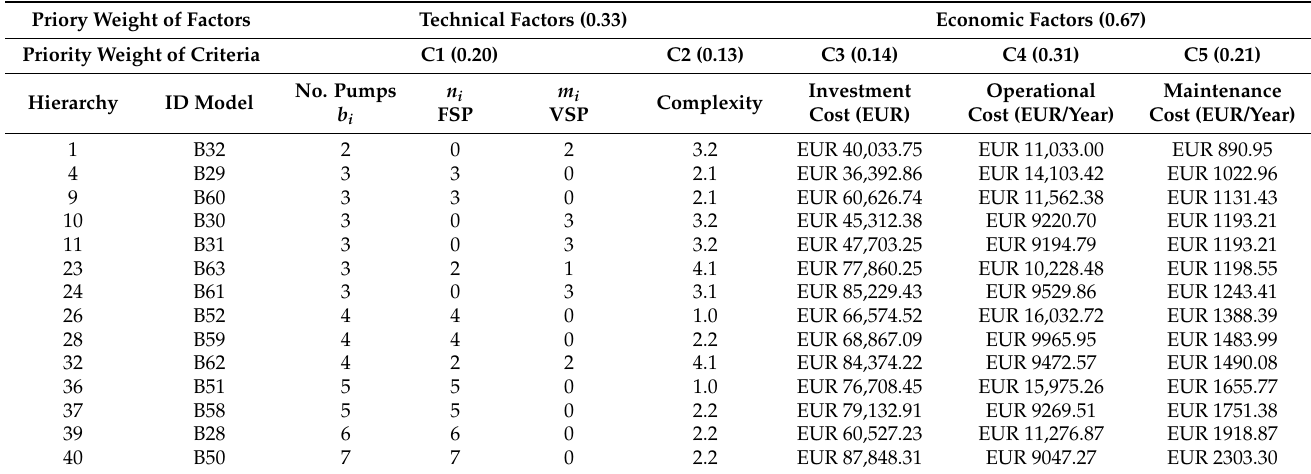
Table 10. Assessment of the criteria for each alternative (TF-PS2).